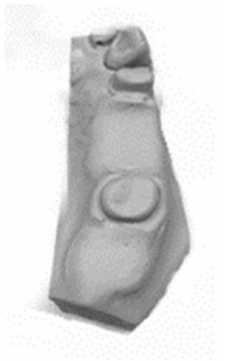
Figure 2. The model targeted area for the